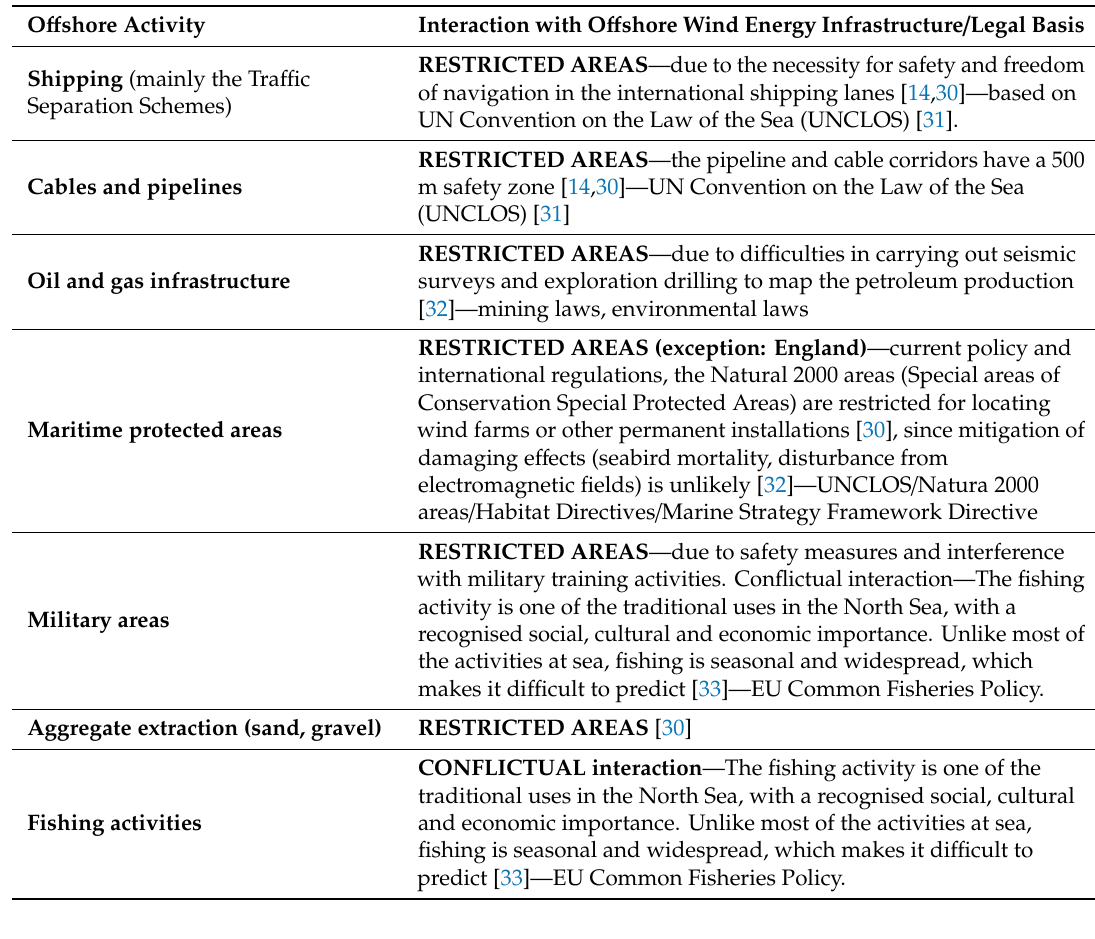
Table 3. Interactions with wind energy infrastructure—Status-quo.